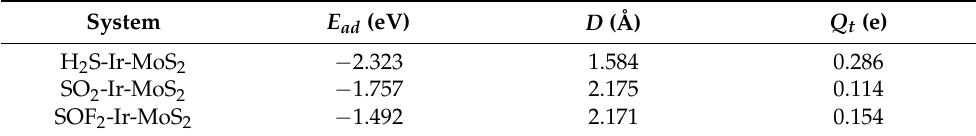
Figure 7. The most stable structures of SF 6 decomposition components adsorbed on the Ir-modified MoS 2 monolayer. Table 2. The parameters of different Ir-modified MoS 2 adsorption systems.